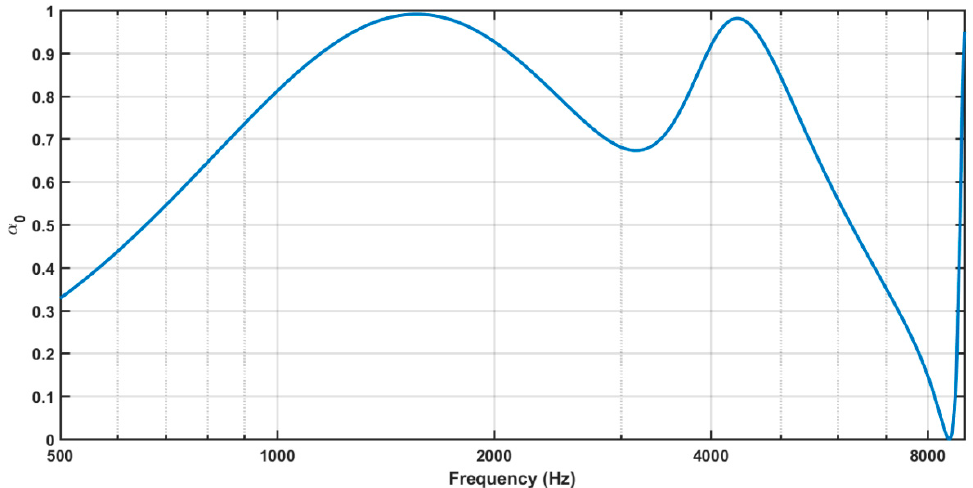
Figure 25. Normal incidence absorption coefficient of a DL-MPP with ( d 1 , t 1 , φ 1 , D 1 , d 2 t 2 , φ 2 , D 2 ) = (0.15 mm,1 mm,10%,2 cm,0.15 mm,1 mm,15%,2 cm).